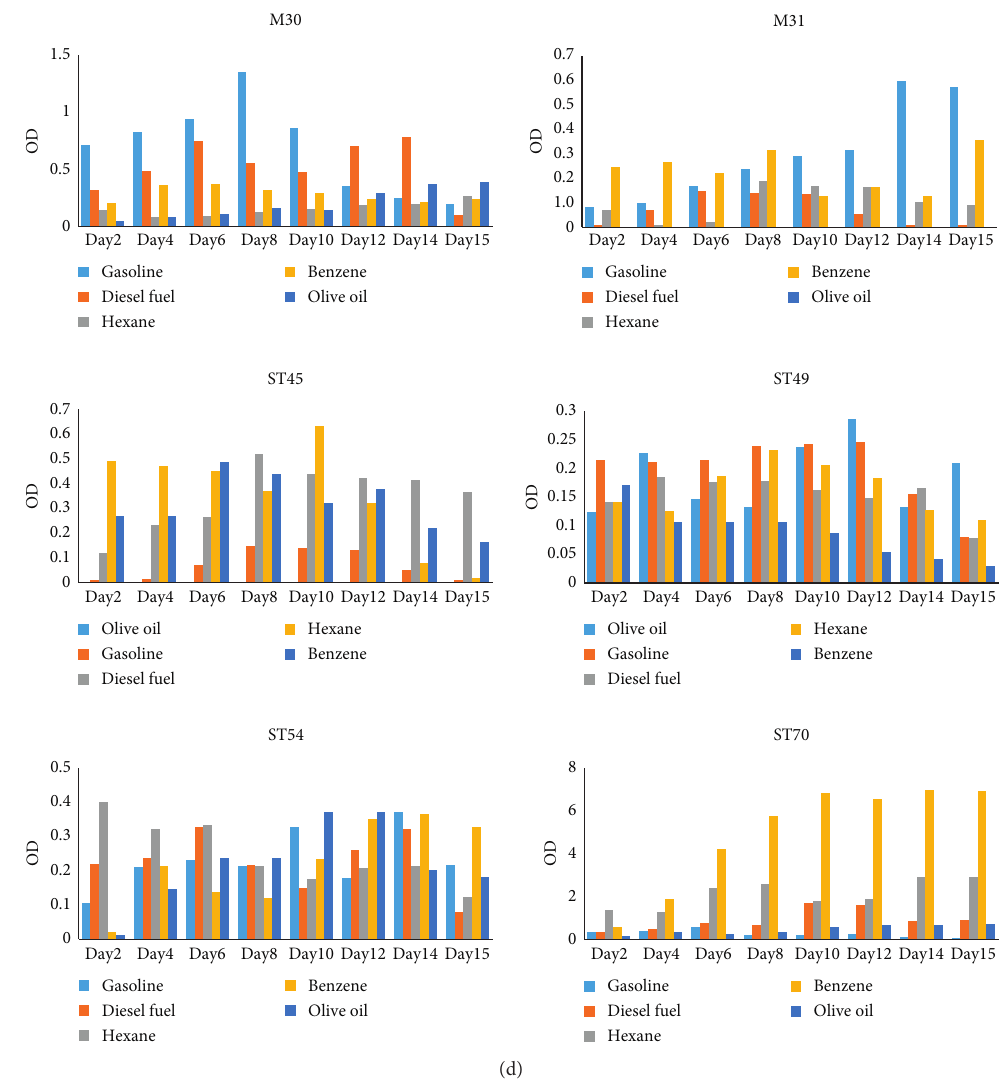
Figure 1: The growth of selected isolates on BH medium supplemented with 2% gasoline, diesel, benzene, hexane, and olive oil. OD given in the y -axis, and the number of days is given in the x -axis. Bacillus species isolates are SB1, SB2, SB3, SB4, SB5, SB6, SB7, SB8, SO5, SO9, SO10, SO14, SO17, SO18, M14, M21, M22, M23, M24, M25, M26, M27, M28, M29, M30, M31, ST45, ST49, ST54, and